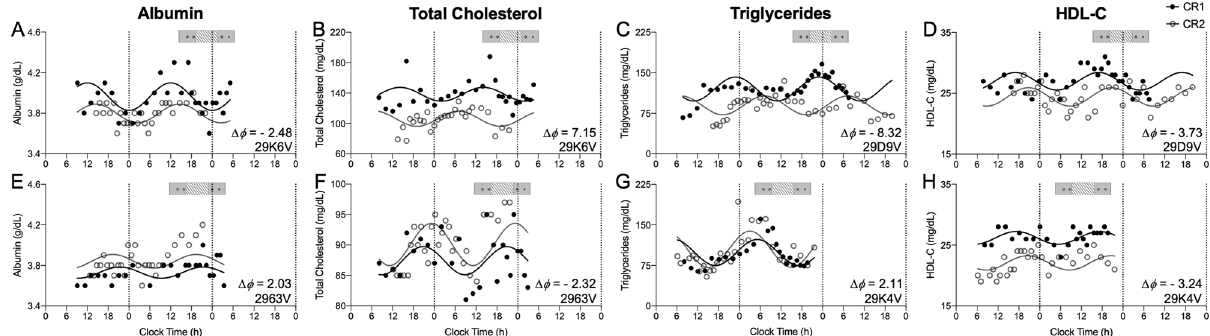
Fig. 2 Examples of rhythms in CR1 and CR2. Data collected during CR1 (black fi lled circles) and CR2 (grey open circles) for ( A , E ) albumin, ( B , F ) total cholesterol, ( C , G ) triglycerides, and ( D , H ) HDL-C. The x -axis is the time each blood sample was taken and the y -axis is the clinical assay concentration. The solid black line is the fi tted cosinor regression for CR1 and the grey solid line is the fi tted cosinor regression for CR2. The phase shift ( Δϕ ) and participant ID for each example is noted in the bottom right corner of the plots. The exposure day schedule is represented in the bar above the plots; grey bars indicate wake episodes in ambient light <3 lux, hatched bars indicate the 6.5-h light exposure (LE), and the open circles indicate the timing of meals and snacks.